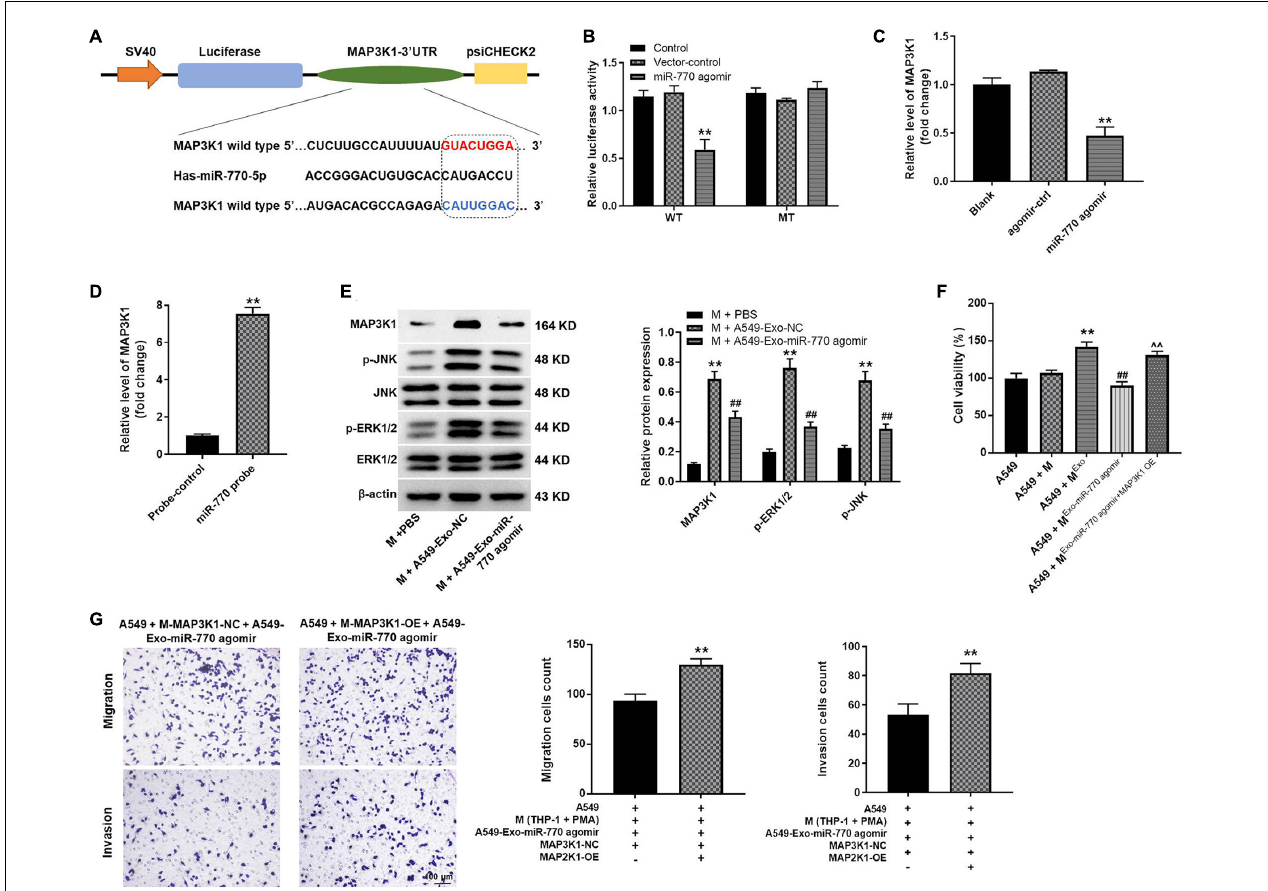
FIGURE 7 | MAP3K1 was found to be the direct target of miR-770. (A) The potential target of miR-770 was predicted by targetscan. (B) The relative luciferase activity was detected by dual luciferase reporter assay. (C) Macrophages were transfected with agomir-ctrl or miR-770 agomir. Then, the level of MAP3K1 in macrophages was detected by RT-qPCR. (D) The correlation between miR-770 and MAP3K1 was tested by RNA pull-down. (E) Macrophages were co-cultured with A549-Exo-NC or A549-Exo-miR-770 agomir. The protein levels of MAP3K1, p-ERK1/2, ERK1/2, JNK or p-JNK in macrophages were detected by western blot. The relative expressions were quantified by normalizing to β -actin. (F) The viability of NSCLC cells was tested by CCK-8 assay. (G) The migration and invasion of NSCLC cells was tested by transwell assay. N = 3; ∗∗ P < 0.01 compared to M + PBS or A549 + M-MAP3K1-NC + A549-Exo-miR-770 agomir, ## P < 0.01 compared to M +